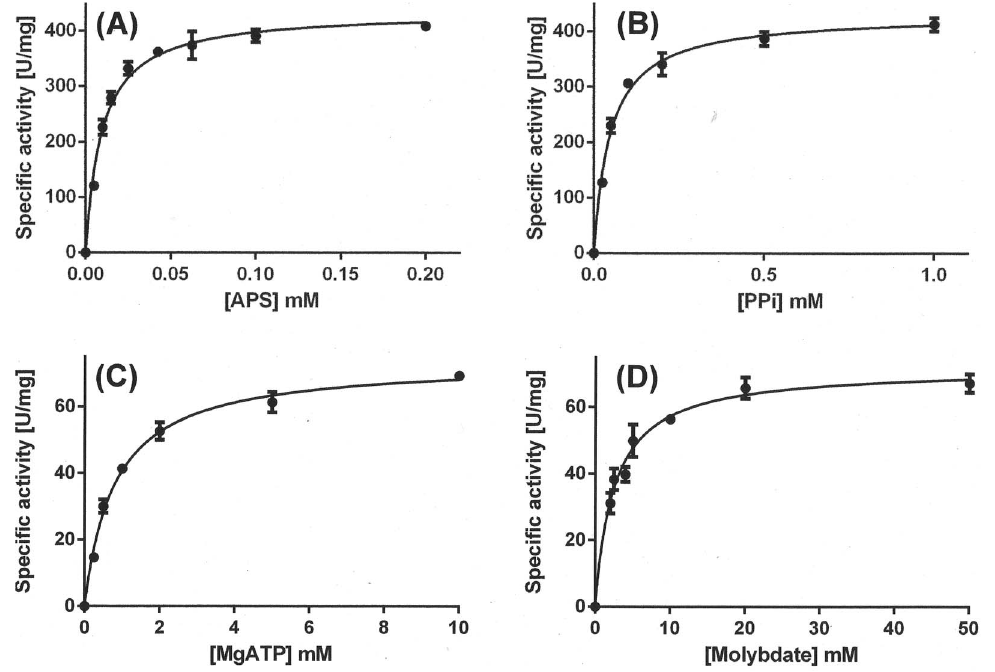
Figure 1. Kinetics of recombinant ATP sulfurylase from A.vinosum . [A] v versus [APS] in the ATP synthesis reaction at 1 mM pyrophosphate. [B] v versus [PP i ] at 0.2 mM APS. [C] v versus [MgATP] in the molybdolysis reaction at 50 mM MoO 42 2 . [D] v versus [molybdate] in the molybdolysis reaction at 10 mM MgATP. Each data point is the mean 6 standard deviation of three assays on the same batch of protein but in some cases the error bars are too small to be seen. The solid lines through the data points are the fits to the Michaelis-Menten equation using non-linear regression as described in Materials and Methods.